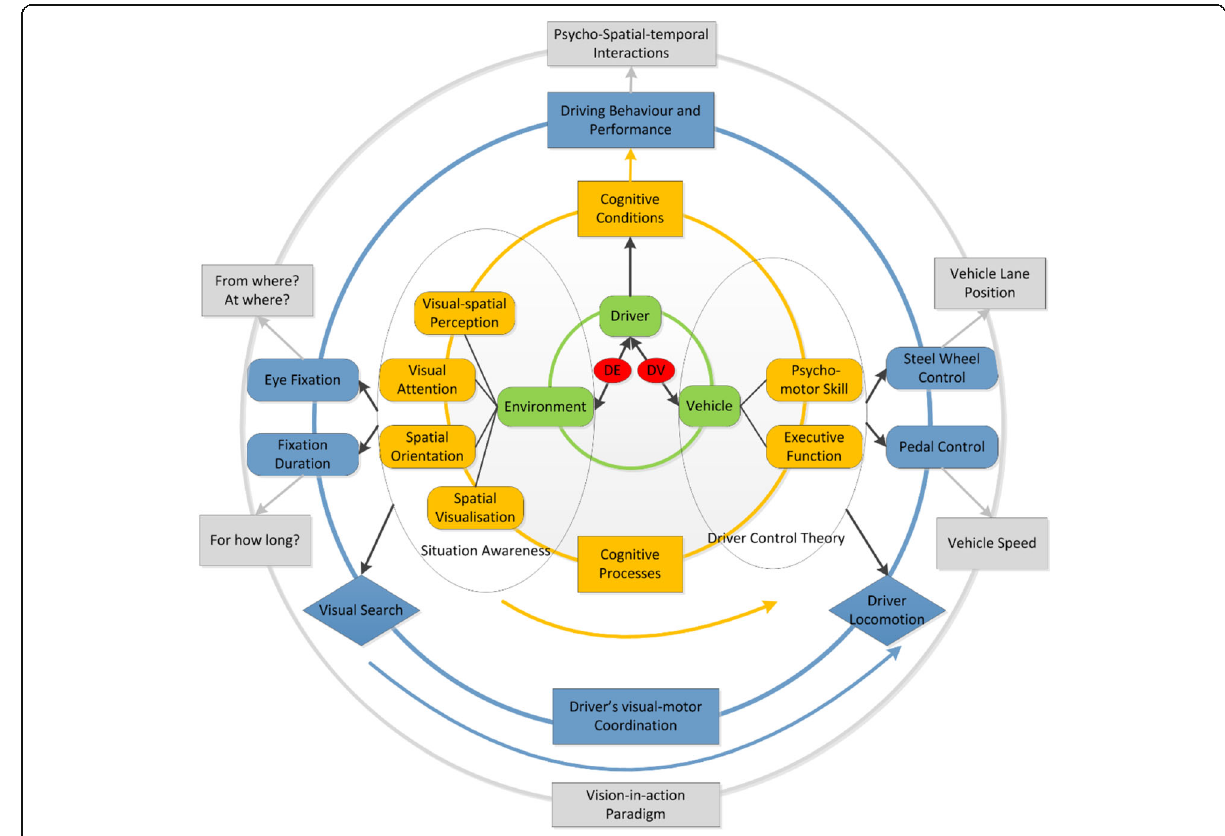
Fig. 1 A conceptual driving behaviours and cognitive processes